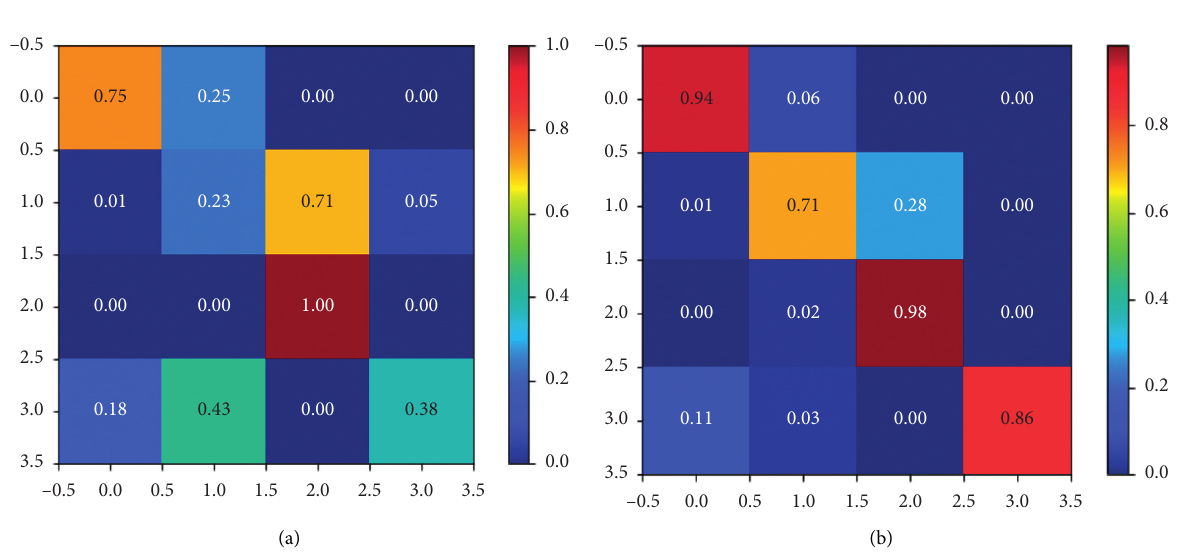
Figure 10: Confusion matrix of transfer learning results. (a) Confusion matrix without transfer learning; (b) Confusion matrix after transfer